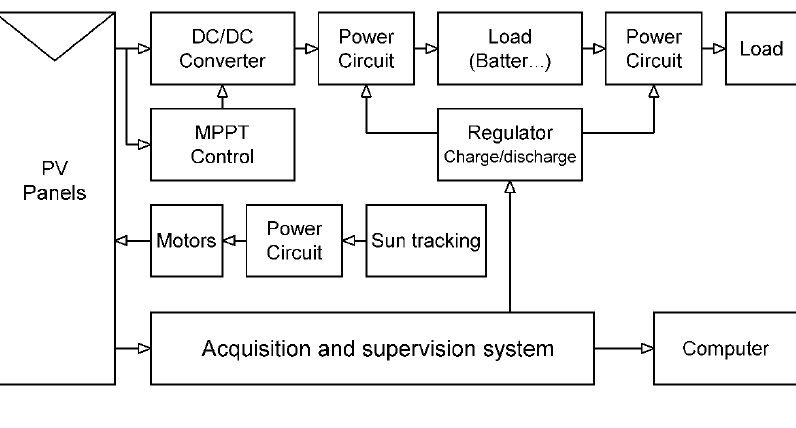
Figure 1. Synoptic diagram of the photovoltaic